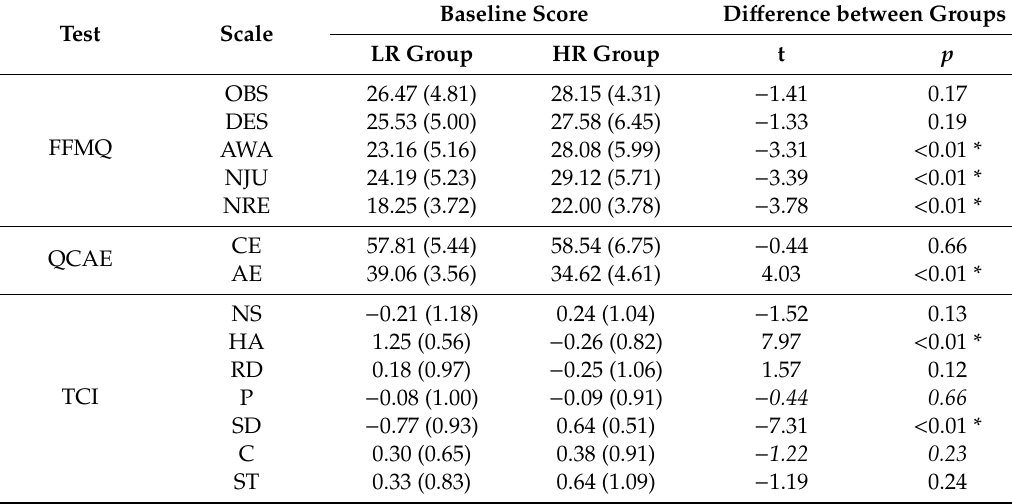
Table 2. Baseline data (expressed as average score and standard deviation) and between-group statistical di ff erences. For baseline data, raw scores are used for all measures except TCI, for which z-scores are reported (obtained using a large control sample of healthy individuals—see Table S3 in [84]). Text in italics indicates that results were obtained using a robust version of the t